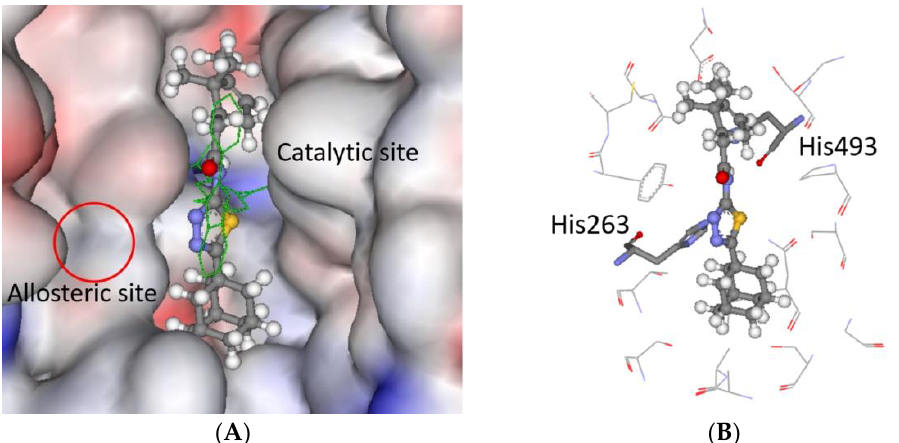
Figure 4. The docked pose of 15b in the catalytic site of TDP1 as predicted by the ChemPLP scoring function. ( A ) The ligand is shown in the ball-and-stick format. The catalytic pocket is to the right-hand site, the co-crystallised ligand is depicted as green lines. The allosteric pocket is not predicted to be occupied (see circled area). The protein surface is rendered; blue depicts regions with a partial positive charge on the surface; red depicts regions with a partial negative charge; grey shows neutral areas. ( B ) The predicted configuration is depicted as balls-and-sticks, no specific interaction between the ligand and protein was predicted. The catalytic His263 and His493 amino acid residues are shown as sticks. The adjacent amino acids (<5 Å ), buttressing the ligand, are shown as lines. The amino acids’ hydrogens are not shown for clarity.